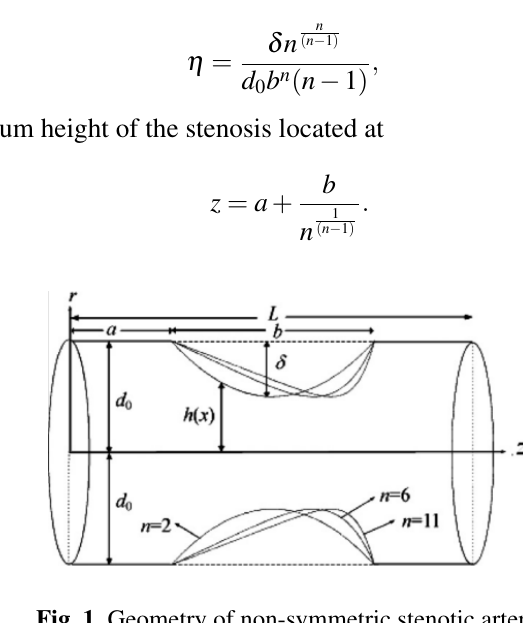
Fig. 1 Geometry of non-symmetric stenotic